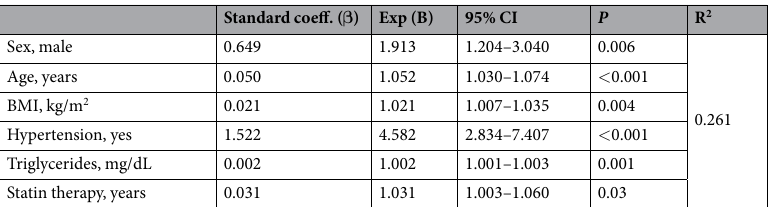
Standard coeff. ( β ) Exp (B) 95% CI P R 2 Sex, male 0.649